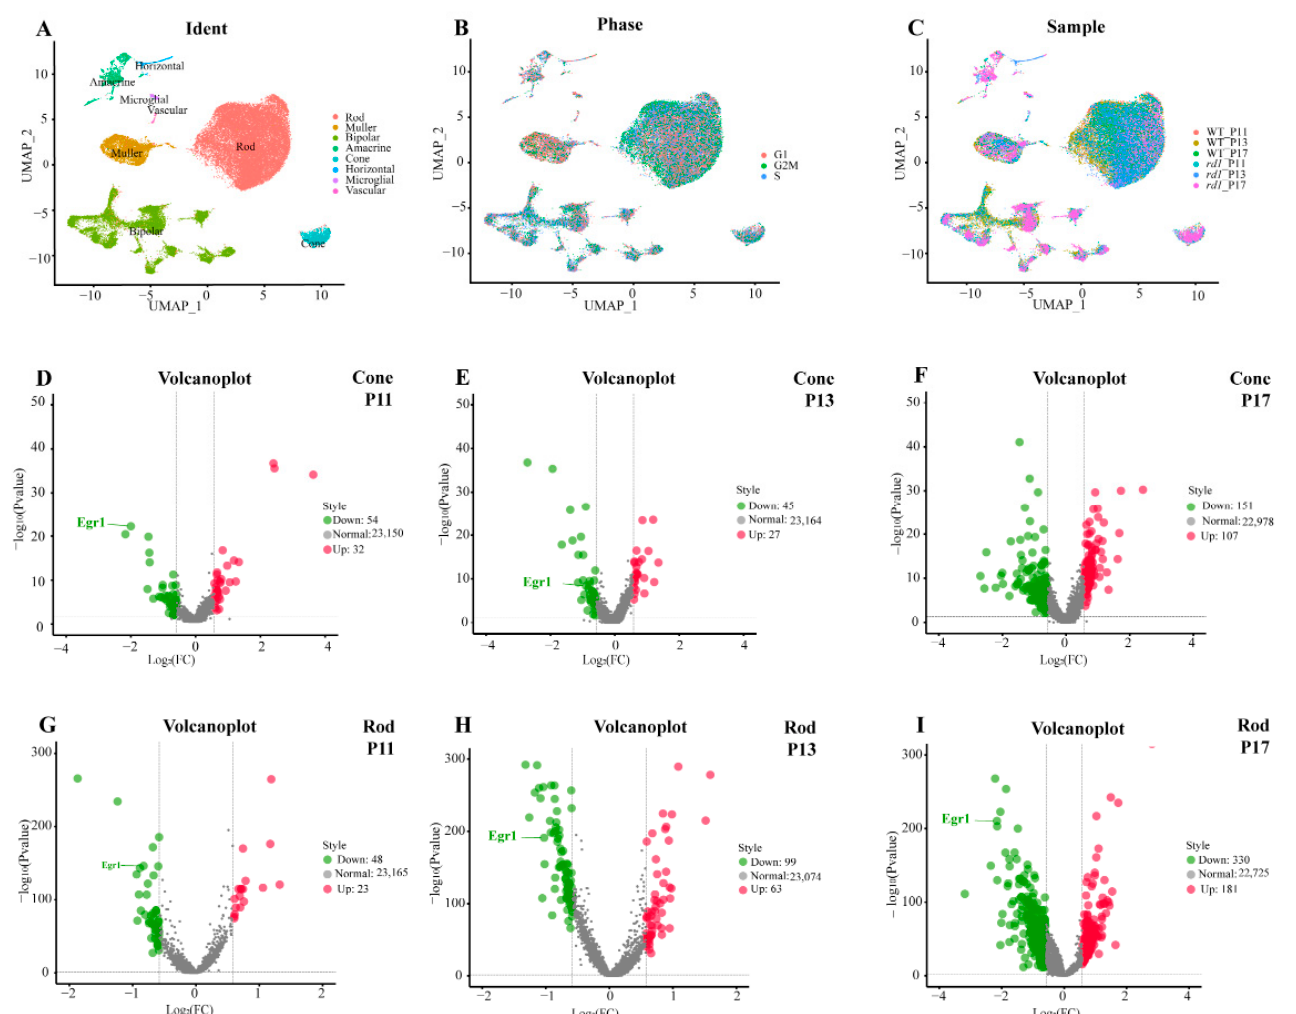
Figure 1. Single-cell RNA-seq analysis of wild-type and rd1 rod and cone photoreceptors. ( A ) Dis- tribution of cell clusters between wild-type (WT) and rd1 mice. ( B ) Cell cycle of all cell clusters. ( C ) Cellular composition of sub-clusters in WT and rd1 mice. ( D – I ) Volcano plots showing differentially expressed genes (|avg_logFC| > 0.58, p < 0.05) that were significantly downregulated (green) or upregulated (red) in rods and cones at P11, P13, and P17 in WT vs. rd1 retinas. Note the prominent regulation of EGR1 in rod and cone photoreceptors.